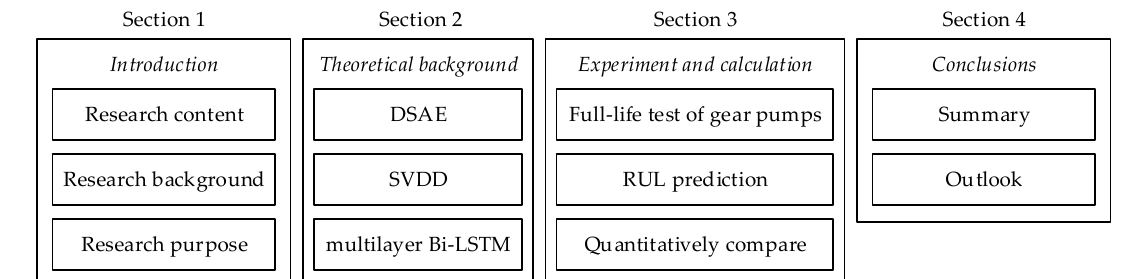
Figure 1. The structure of this paper.